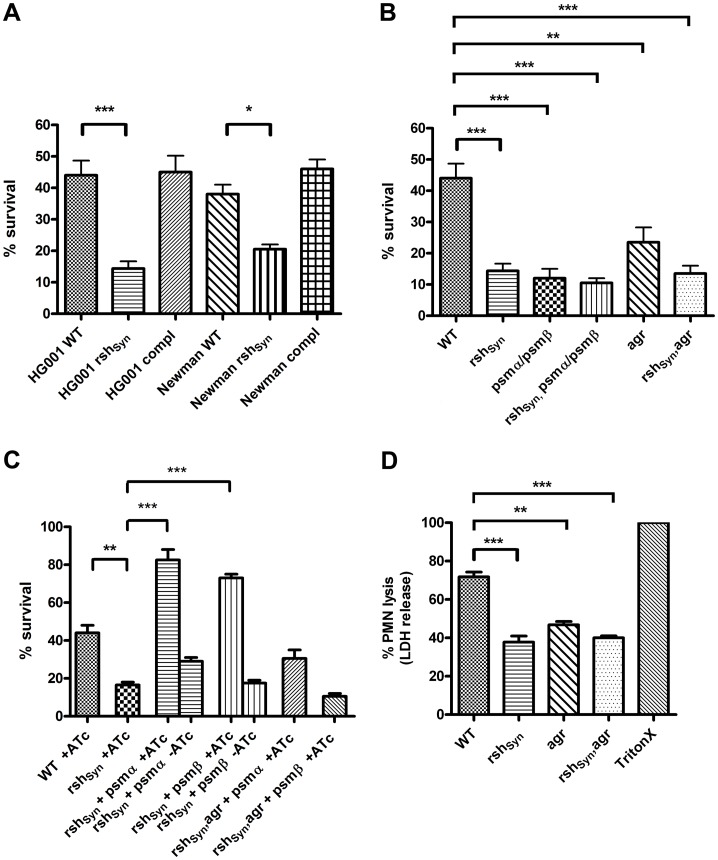
Phagocytosis killing assays and a PMN lysis assay with different S. aureus strains.(A) and (B) Survival of wild-type S. aureus strain HG001 and strain Newman (WT), and their isogenic rshSyn mutants, complementation strains (compl), psmα, psmβ double mutants (HG001), rshSyn, psmα, psmβ triple mutants (HG001), agr mutant (HG001) and rshSyn, agr double mutant (HG001) were determined after phagosomal uptake by counting colony-forming units after 60 min incubation. Bacterial cells used for the experiment were harvested at similar points of growth at an OD600 of 1.0. The levels of significance were determined by the two-tailed Student t test (p<0.05). (C) Complementation of survival of the rshSyn mutant with tetracycline inducible psmα and psmβ. Therefore membrane permeable anhydrotetracycline (ATc) 0.1 µg/ml was used to induce psm expression after phagosomal uptake of the bacteria. The levels of significance were determined by the two-tailed Student t test (p<0.05). (D) Lysis of PMNs, as measured by release of lactate dehydrogenase (LDH) activity. PMN lysis was determined after a phagocytotic interaction of 60 min with S. aureus strain HG001 wild-type, corresponding rshSyn mutant, agr mutant and rshSyn, agr double mutant. As a positive control 2% TritonX were used. The levels of significance were determined by the two-tailed Student t test (p<0.05).